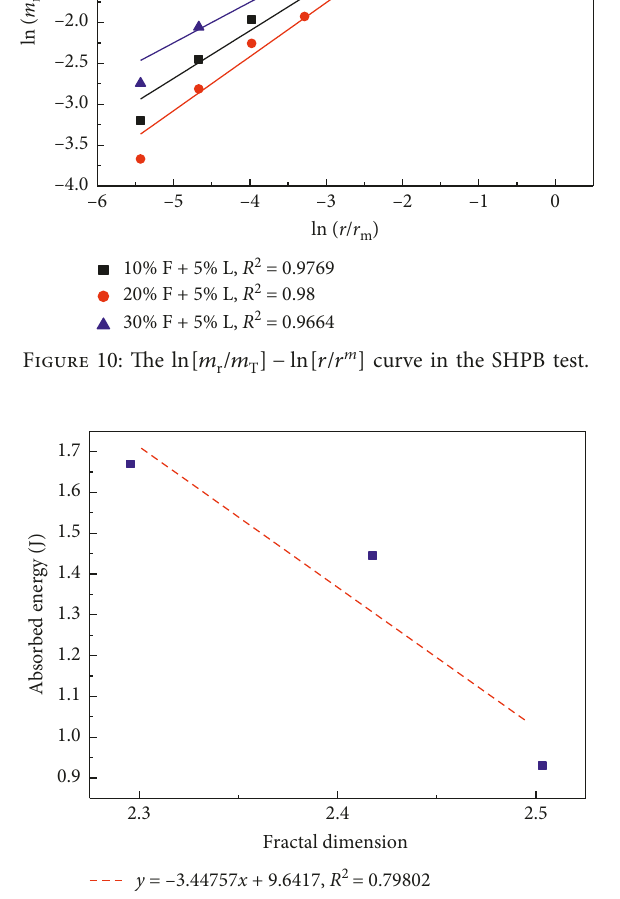
Figure 11: Fitted curve of fractal dimension and absorbed energy of stabilized